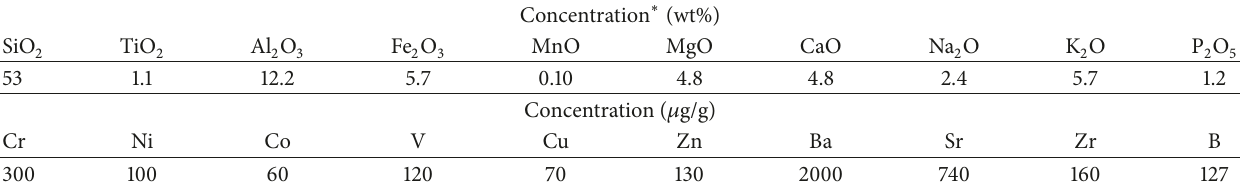
Table 1: Elemental composition of basaltic rock obtained using ICP-OES analysis [4].